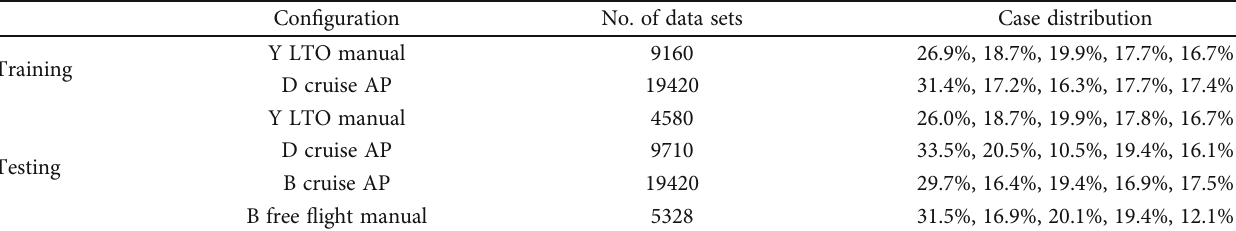
Table 4: Example of confusion matrix.